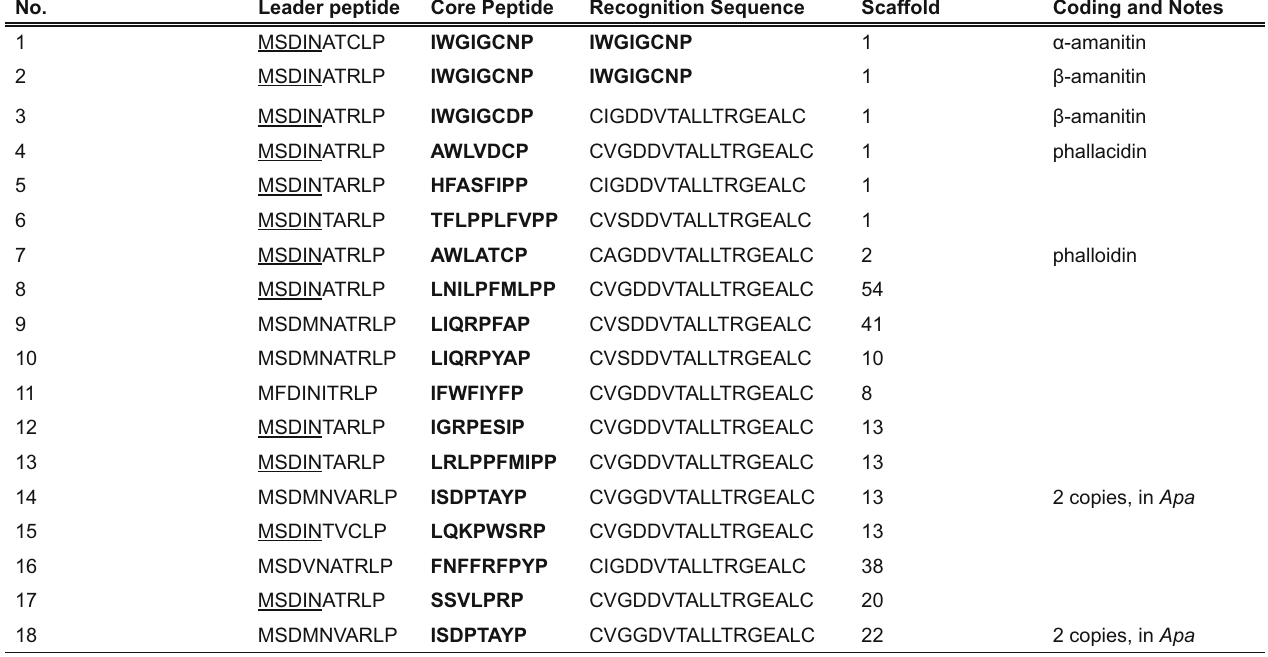
Core peptides (correspond to cyclic peptide toxins) are in bold. The conserved MSDIN (except for the ones with variations) is underlined.